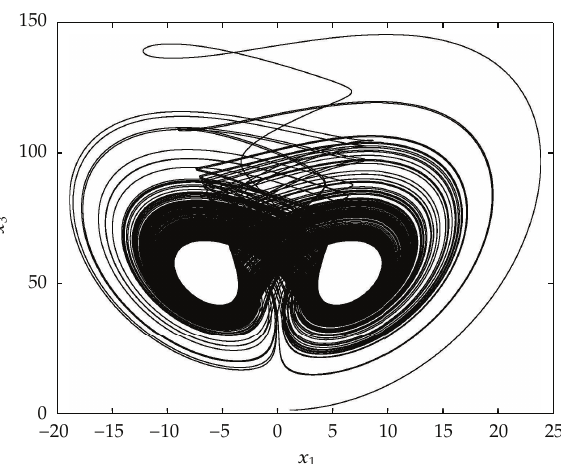
Figure 1: Chaotic behavior of the master chaotic system under the proposed